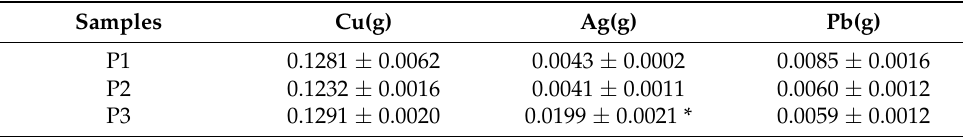
Table 1. Results from the AAS for P1, P2, and P3 samples.